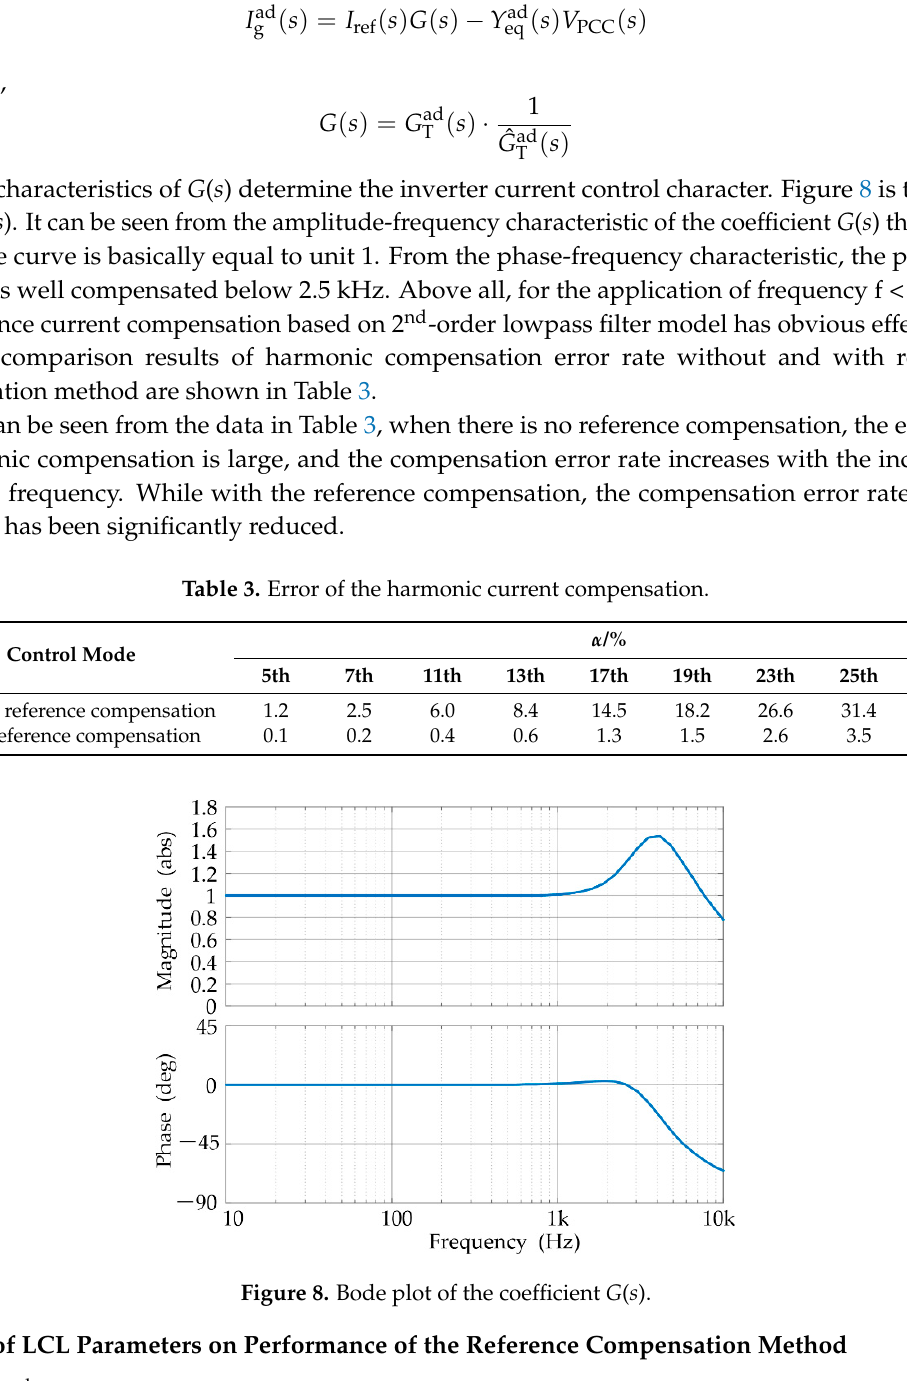
Table 4. LCL parameters for comparison.